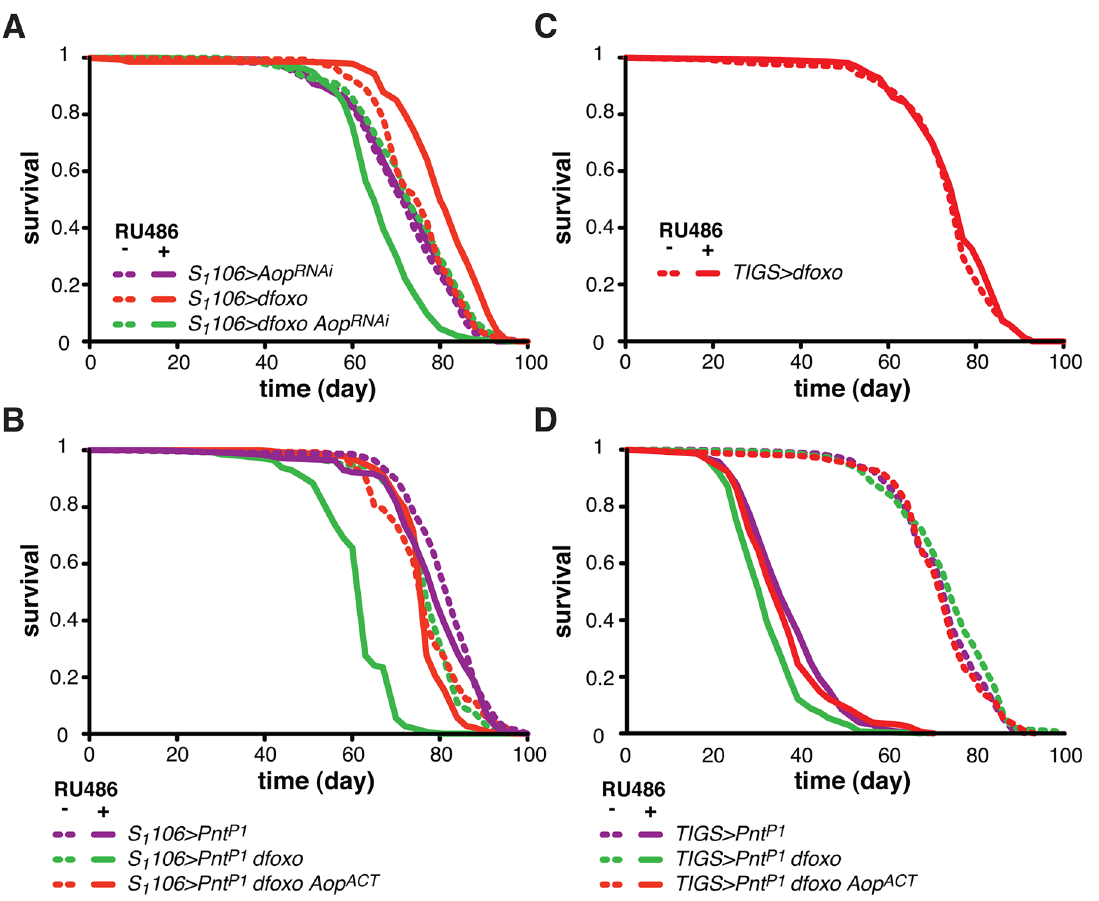
Figure 4. Aop prevents the detrimental effects of dfoxo and Pnt co-activation. A Survival of female flies expressing dfoxo , Aop RNAi or both under the control of S 1 106 in the presence or absence or RU486. Log-rank test revealed significant effect of RU486 for S 1 106 . dfoxo (p , 10 2 4 ; total dead/censored: 2 RU486 145/0, + RU486 139/6; median/maximum lifespan: 2 RU486: 77/87, + RU486 80/90) and S 1 106 . dfoxo Aop RNAi (p , 10 2 4 ; total dead/censored: 2 RU486 145/2, + RU486 155/2; median/maximum lifespan: 2 RU486: 74/90, + RU486 65/79) but not S 1 106 . Aop RNAi (p=0.5; total dead/censored: 2 RU486 142/0, + RU486 147/4; median/maximum lifespan: 2 RU486: 72/86, + RU486 74/87). CHP analysis showed that the response to RU486 in S 1 106 . dfoxo Aop RNAi was significantly different from the response in S 1 106 . dfoxo (p , 5 6 10 2 15 ) and S 1 106 . Aop RNAi (p , 10 2 7 ) females. B Survival of female flies expressing dfoxo , PntP1 and Aop ACT under the control of S 1 106 in the presence or absence or RU486. Log-rank test revealed significant effect of RU486 for S 1 106 . Pnt P1 dfoxo (p , 10 2 4 ; total dead/censored: 2 RU486 138/6, + RU486 145/2; median/maximum lifespan: 2 RU486: 77/90, + RU486 63/83) but not S 1 106 . Pnt P1 (p=0.06; total dead/censored: 2 RU486 147/0, + RU486 143/2; median/maximum lifespan: 2 RU486: 84/92, + RU486 79/90) or S 1 106 . Pnt P1 dfoxo Aop ACT (p=0.1; total dead/censored: 2 RU486 147/3, + RU486 142/3; median/maximum